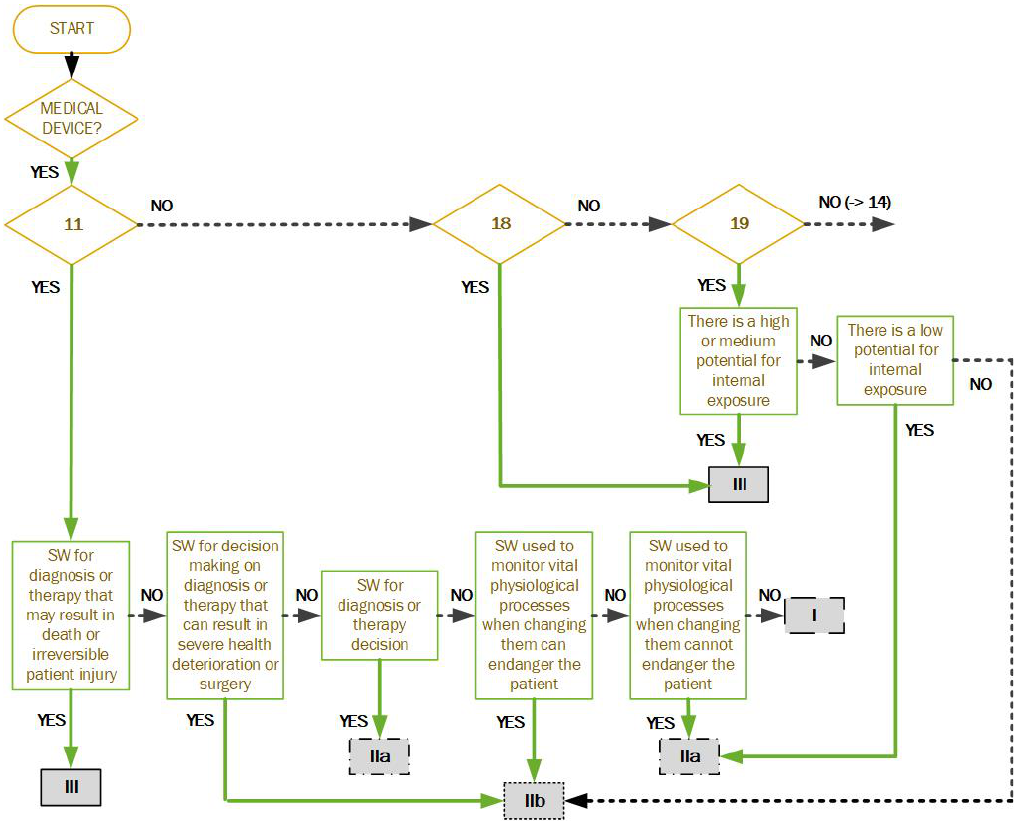
Figure 1. The first phase of the decision. Figure 2: If the first phase does not meet the classification, the manufacturer continues to the second phase. Rule 9—active therapeutic devices intended to exchange or administer energy; Rule